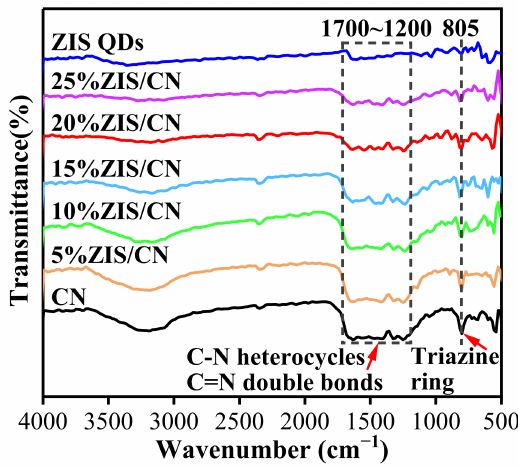
Figure 3. FT-IR Spectra of CN, ZIS QDs, and